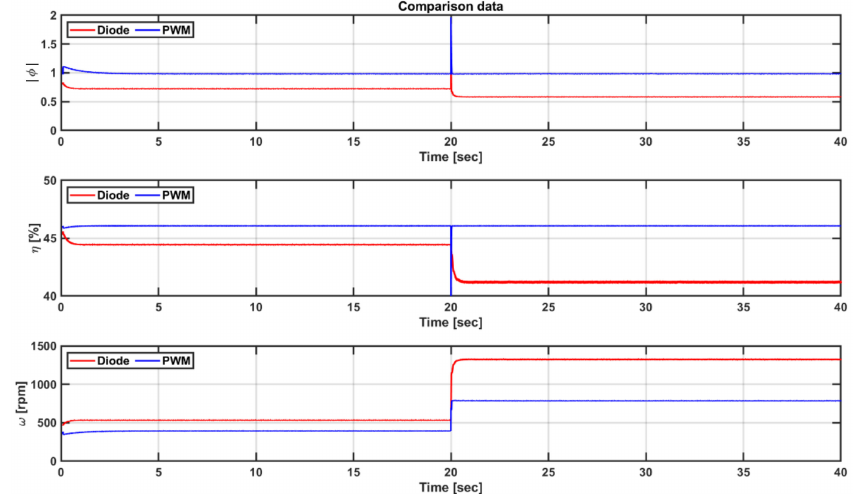
Figure 12. Turbine performance results of a PTO system in integrated simulation during steady and transient conditions at a constant input flow velocity form 14 m / s to 28 m / s.